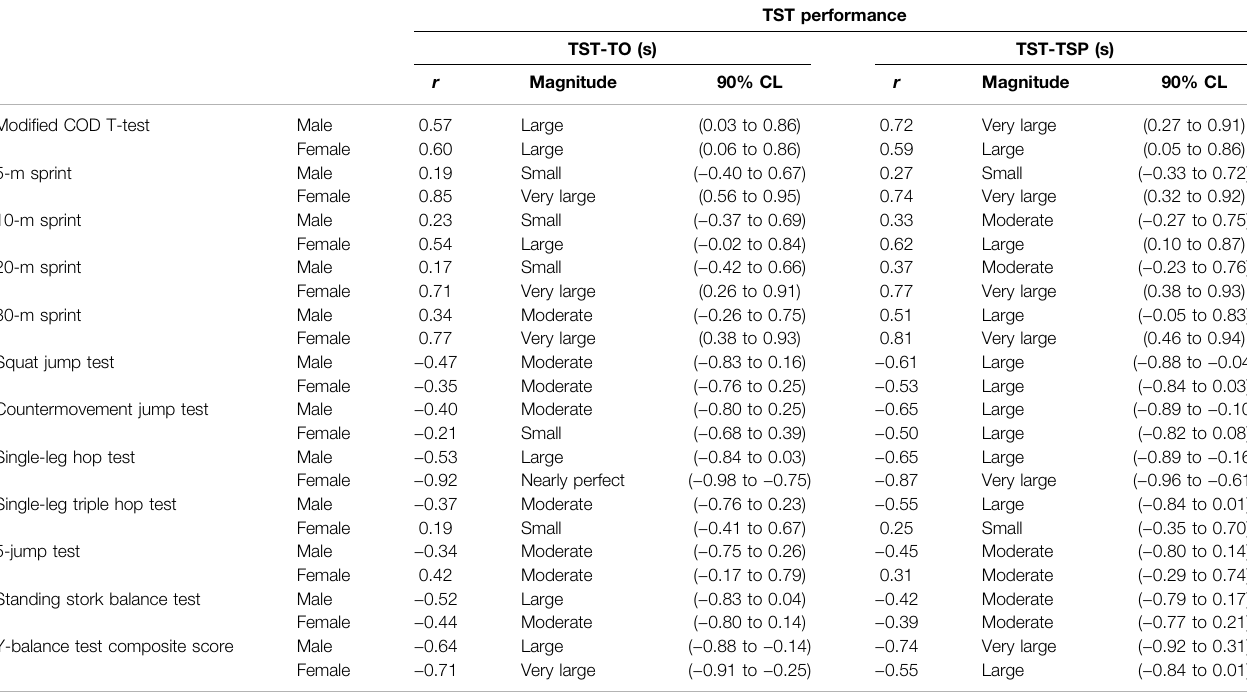
TABLE2| CorrelationoflogtransformedperformancevariablesbetweenTSTandgenericperformancetestsmeasuringCODspeed,balance,speedandjumpperformance in males and